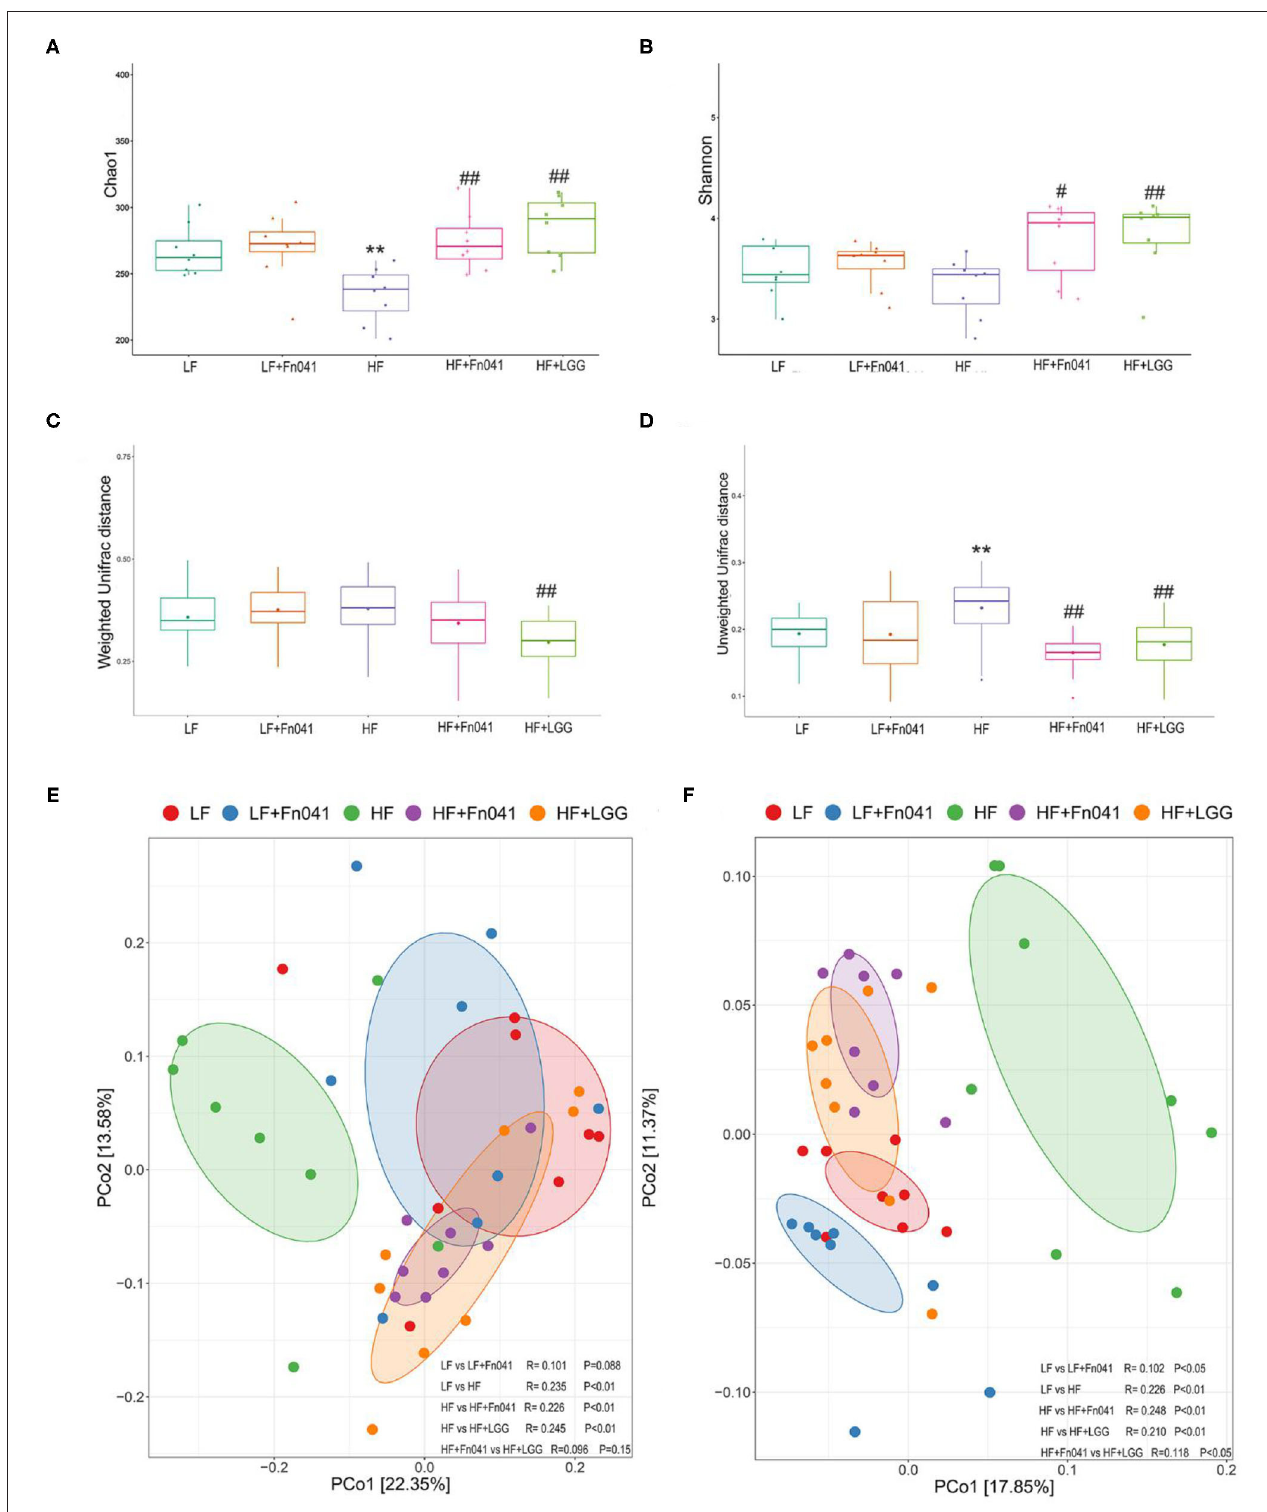
FIGURE 5 | Effect of Lactobacillus reuteri Fn041 on species diversity of microbiota in ileum contents. (A) Chao index; (B) Shannon index; (C) Weighted unifrac distance; (D) Unweighted unifrac distance; (E) Principal coordinate analysis (PCoA) based on weighted unifrac distance. (F) PCoA based on unweighted unifrac distance. ** p < 0.01 as compared with the LF group; # p < 0.05, ## p < 0.01 as compared with the HF group. ( n = 8/group). LF, low-fat diet